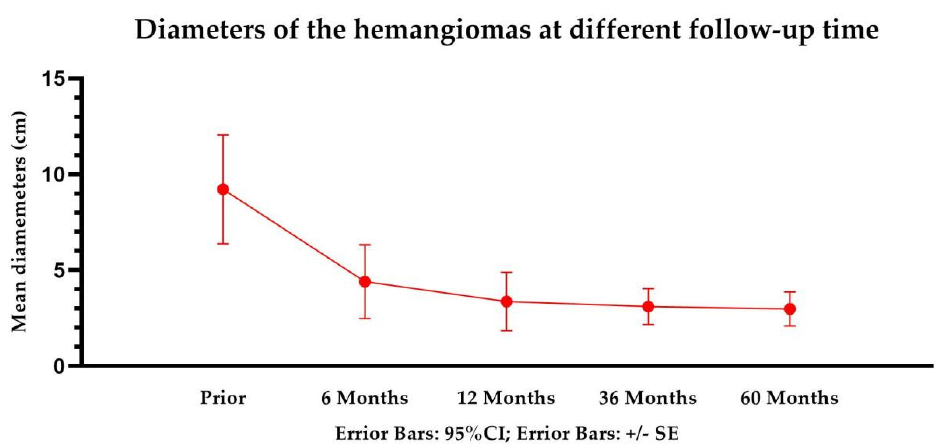
Figure 3. Diameters of the hemangiomas at different follow−up time points. No serious complications were observed after TAE, such as biloma and liver ab- scess, etc. Transient increases of hepatic enzyme (Aspartate transaminase and Alanine transaminase) and plasma bilirubin values were found in all patients after TAE and re-